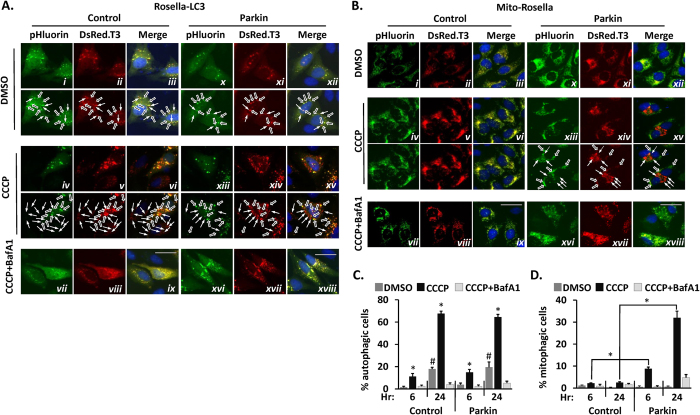
Single-cell measurements of autophagy and mitophagy based on biosensor responses to CCCP treatment.(A) Representative micrographs of HeLa cells transiently co-transfected with Rosella-LC3 expression plasmid plus Parkin expression plasmid or ‘empty’ plasmid (Control). Cells were treated for 24 hr with: Vehicle alone (DMSO), CCCP (10 μM), or CCCP (10 μM) + lysosomal inhibitor Bafilomycin-A1 (BafA1, 100 nM). CCCP-treated cells displayed accumulation of primarily red Rosella-LC3 fluorescence near the central lysosomal compartments (solid arrows in identical, labeled panels below panels vi and xv), while vehicle treated cells primarily display co-localization between red and green signals (hollow arrows in identical, labeled panels below panels iii and xii). Co-treatment with BafA1 (panels ix and xviii) prevented CCCP-induced relocation of Rosella-LC3 to the central lysosomal compartment, causing it to accumulate in autophagasomes within the cytoplasm (panels ix and xviii). (B) Representative micrographs of HeLa cells co-transfected with Mito-Rosella plus either Parkin or Control plasmids, and treated exactly as described above for (A). CCCP treatment caused an accumulation of red-only Mito-Rosella-labeled mitochondria in the central lysosomal compartments in Parkin co-transfected cells but not in control cells (solid arrows in identical, labeled panel below panel xv), and this was inhibited by BafA1 treatment (panel xviii). In contrast, DMSO-treated Parkin-expressing cells (panel xii) and control cells treated with vehicle (DMSO) or CCCP (panels iii and vi), there is a complete co-localization of green/red fluorescence. Quantification of percentage of cells exhibiting induction of (C) autophagy or (D) mitophagy, as determined by categorizing individual cells on the basis of presence/absence of visible accumulations of red biosensor fluorescence in the lysosomal compartments as in (A) and (B) above. For panels C and D: bars represent mean ± SEM of percentages of cells from n = 4 biological replicates, with >120 cells categorized per replicate. For panels A and B: scale bars indicate a length of 25 μm. For panel C: *p <  0.05 vs. DMSO treated cells at the same time-point; and #p  <  0.05 vs. 6 hr time-point by unpaired T-test. For panel D: *p <  0.05 by unpaired T-test for the indicated comparisons between cells co-transfected with Parkin vs. Control plasmid.